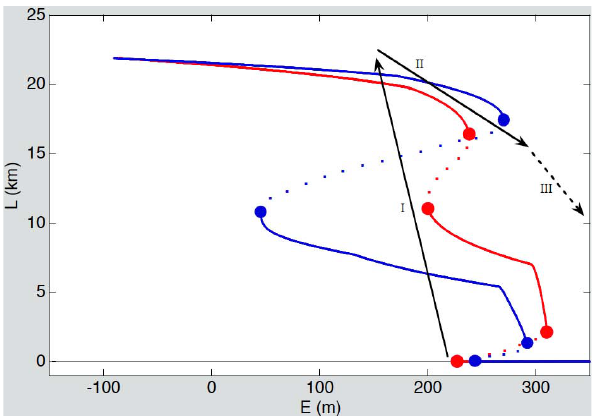
Fig. 9. Equilibrium states of Hansbreen for the present-day bed profile (blue) and assumed pre-LIA bed profile (red). The arrows shows a schematic path of the evolution of Hansbreen as described in the